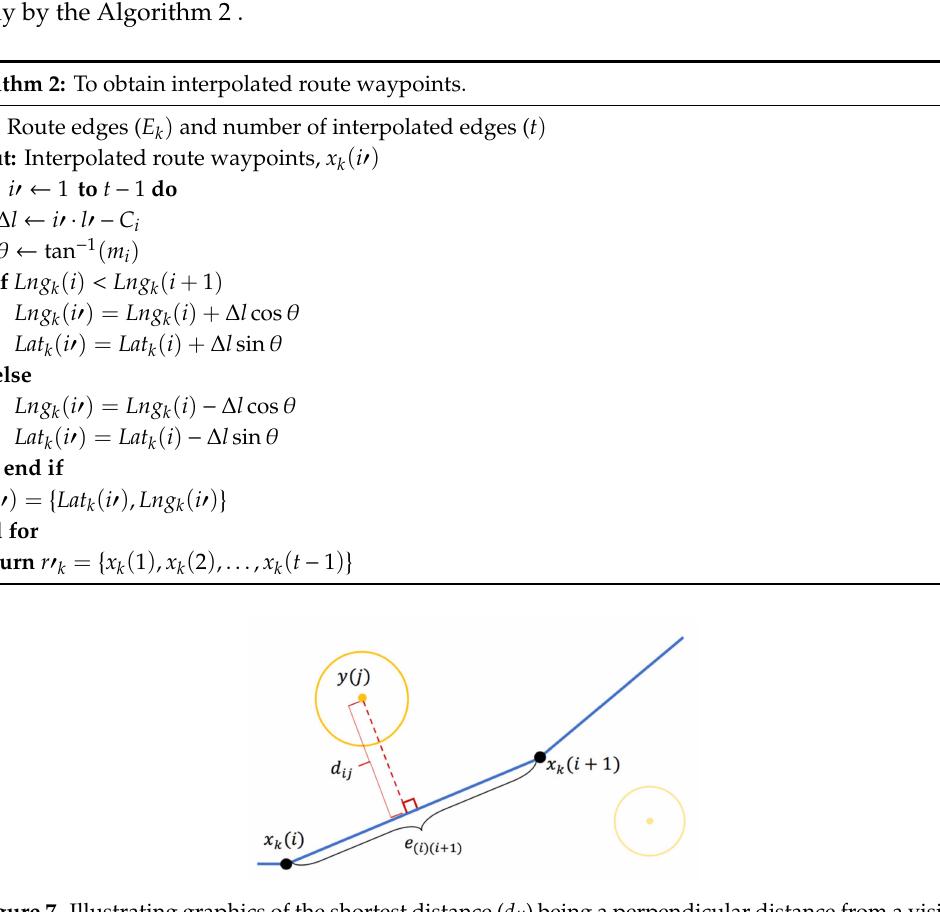
Figure 7. Illustrating graphics of the shortest distance ( d ij ) being a perpendicular distance from a visited cell tower location y(j) to an edge e (i)(i + 1)